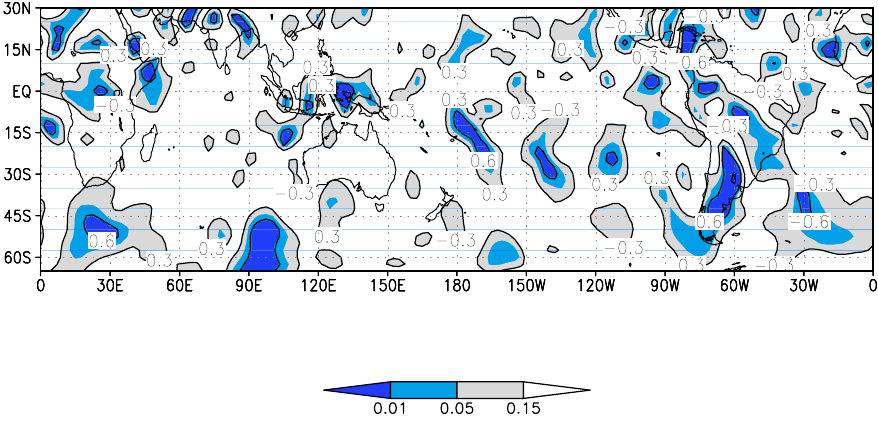
Figure 12 Fig. 12. Correlation fields between the average meridional wind over the Wet Pampa area during GF events and the global meridional wind at 850hPa (lag 0). Only significant values at the 95% level are shown and indicated by the shaded